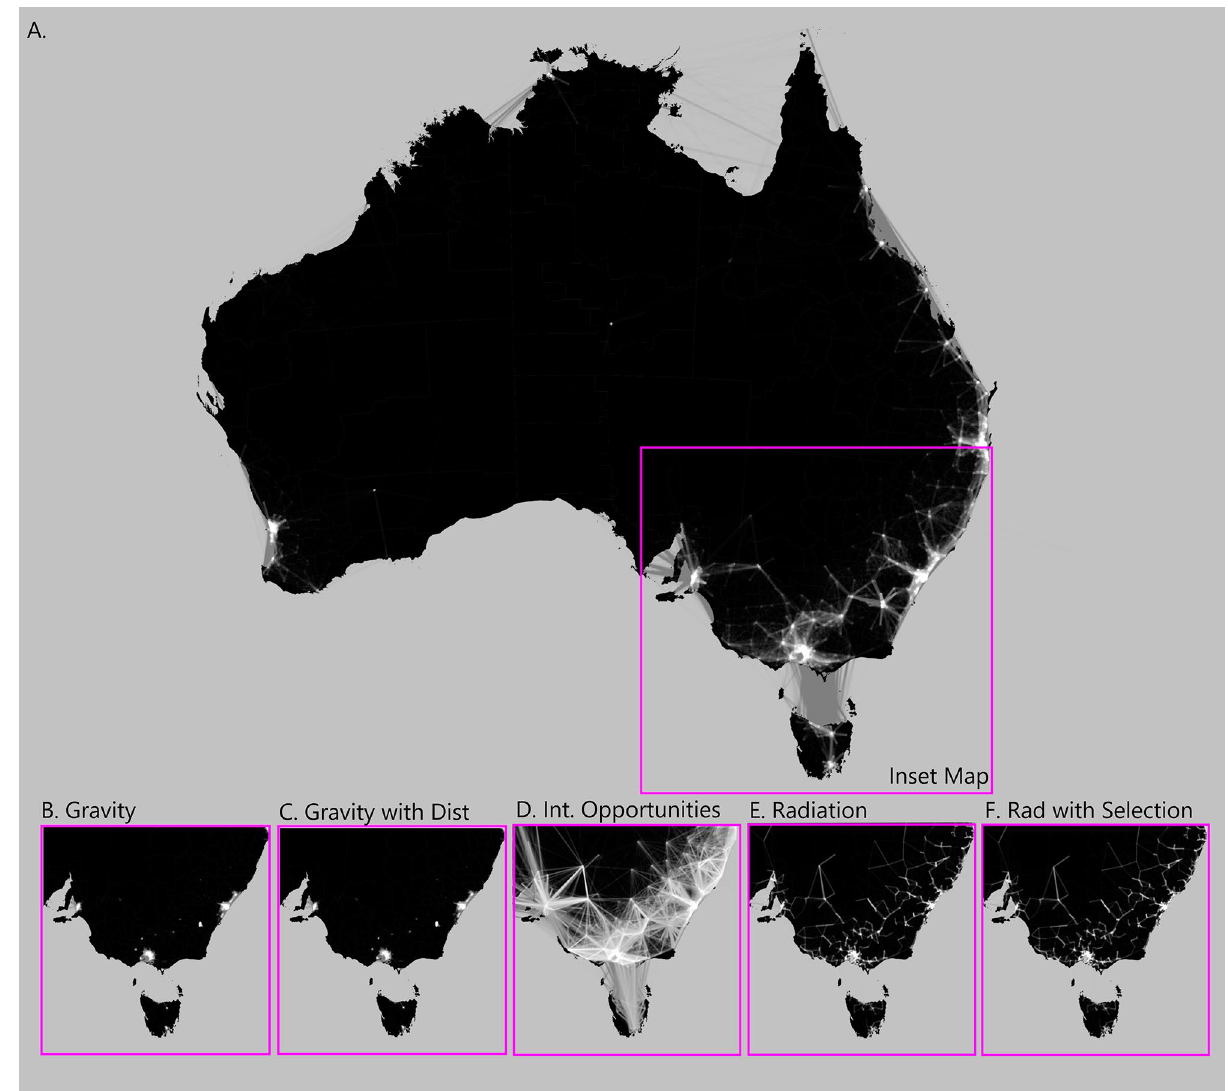
Figure 4. Ensemble model predictions for Australia using ABS census data ( A ). Inset maps for gravity ( B ), gravity with distance ( C ), intervening opportunities ( D ), radiation ( E ) and radiation with selection ( F ) models respectively all trained using ABS data. Movement predictions from each model were scaled to be between 0 and 1 to aid visual comparison. Vivid thick white lines represent high intensity movement, whilst faint thin darker lines represent low intensity movement. The maps in this figure were produced using the R 33 package ggplot2 34 (see Visualisation of predictions section in Methods for further detail). Preview 35 and Paint 3D 36 were used to combine the maps into one image, overlay the squares and add the